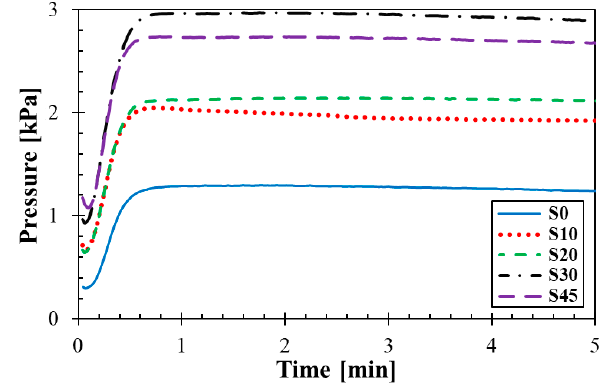
Figure 2. Time dependencies of pressure curves.